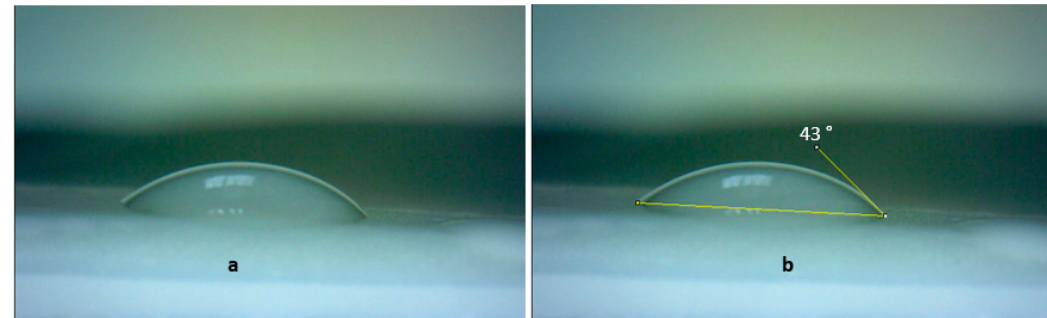
Figure 4. ( a ) Image of the water droplet and ( b ) contact angle measurement with Image J software.